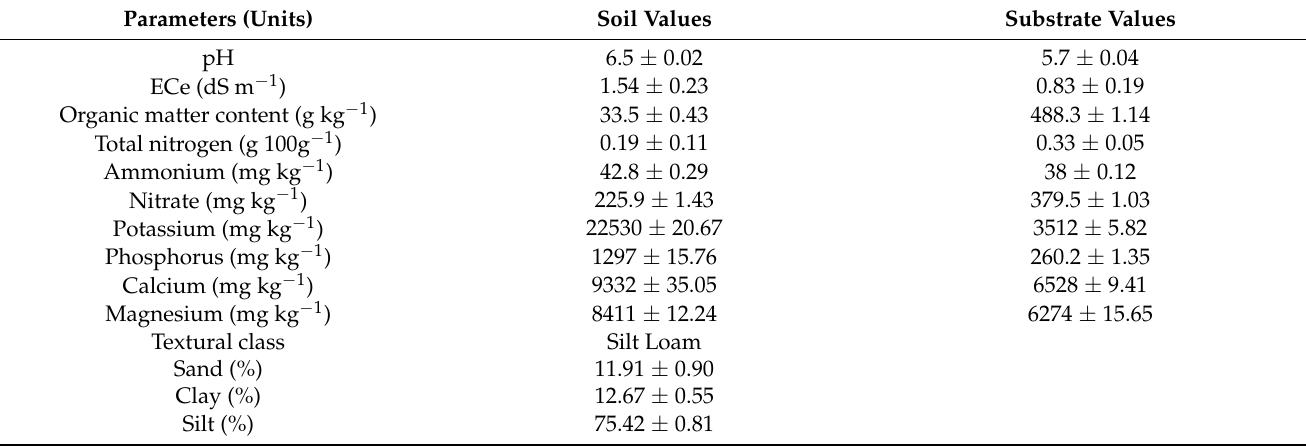
Table 1. Physicochemical properties of soil and substrate cultivation